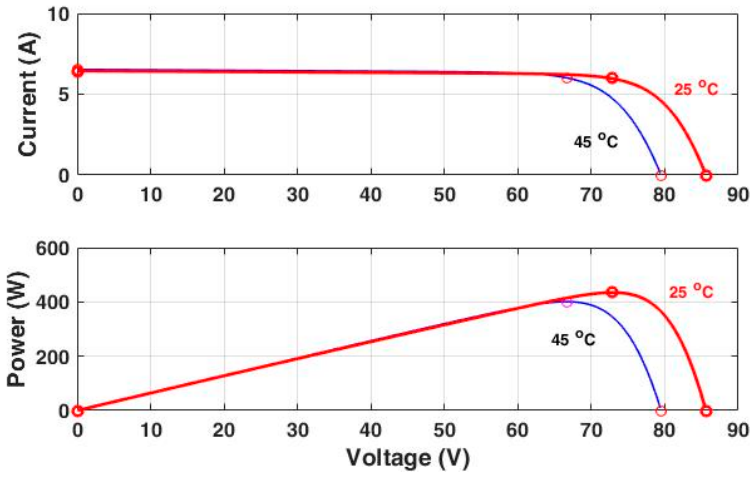
Figure 3. The simulation of characteristics for PV array in [27].